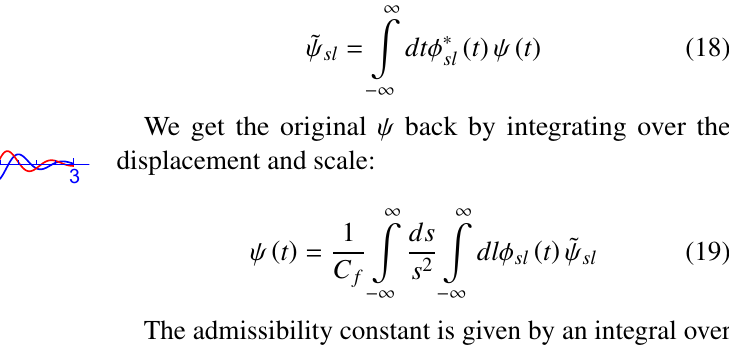
Figure 1: Real and imaginary parts of a mother Morlet wavelet φ ( t ) given by Equation 14 with f = 13